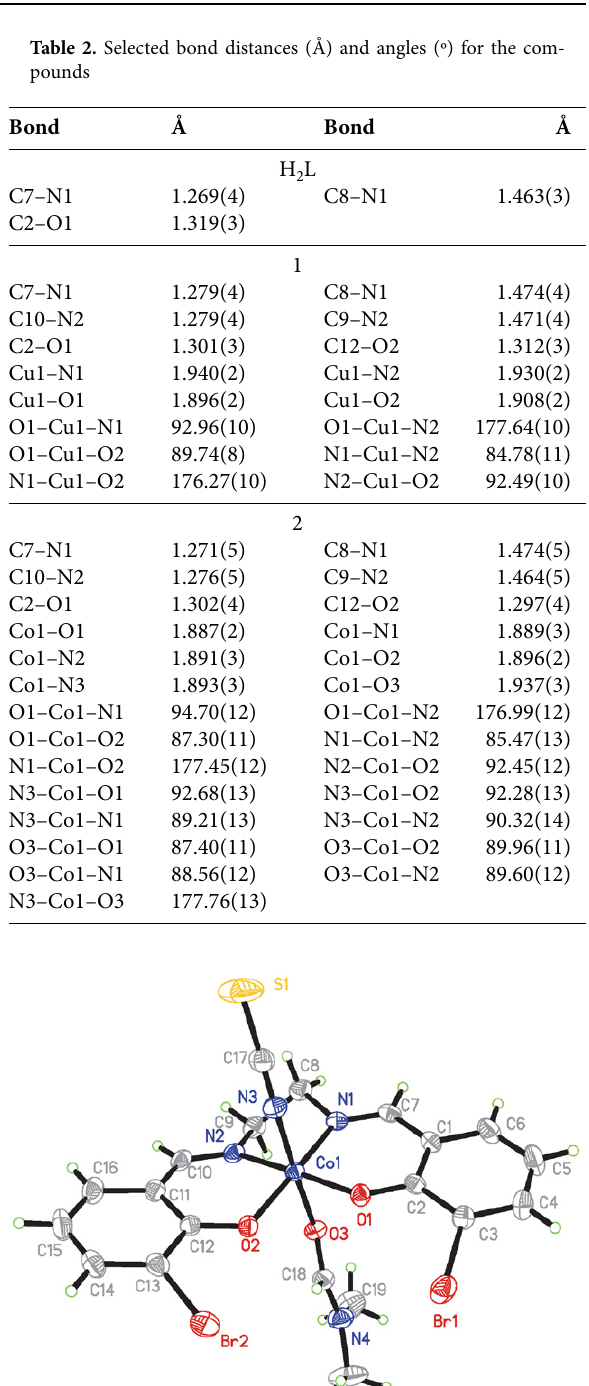
Fig. 3. Molecular structure of complex 1 with thermal ellipsoids of 30% probability level.